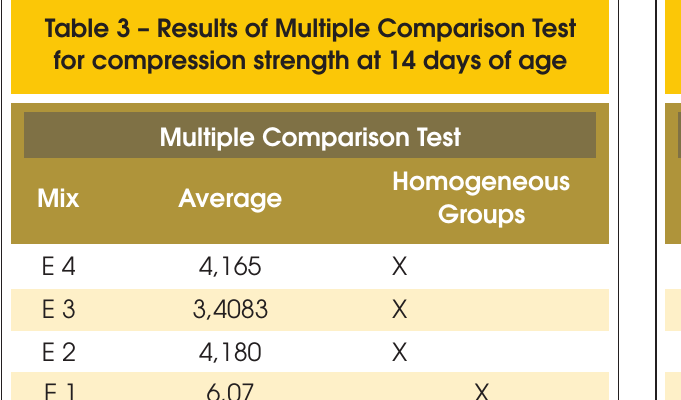
Figura 11 – Average of compressive strength at 14 days